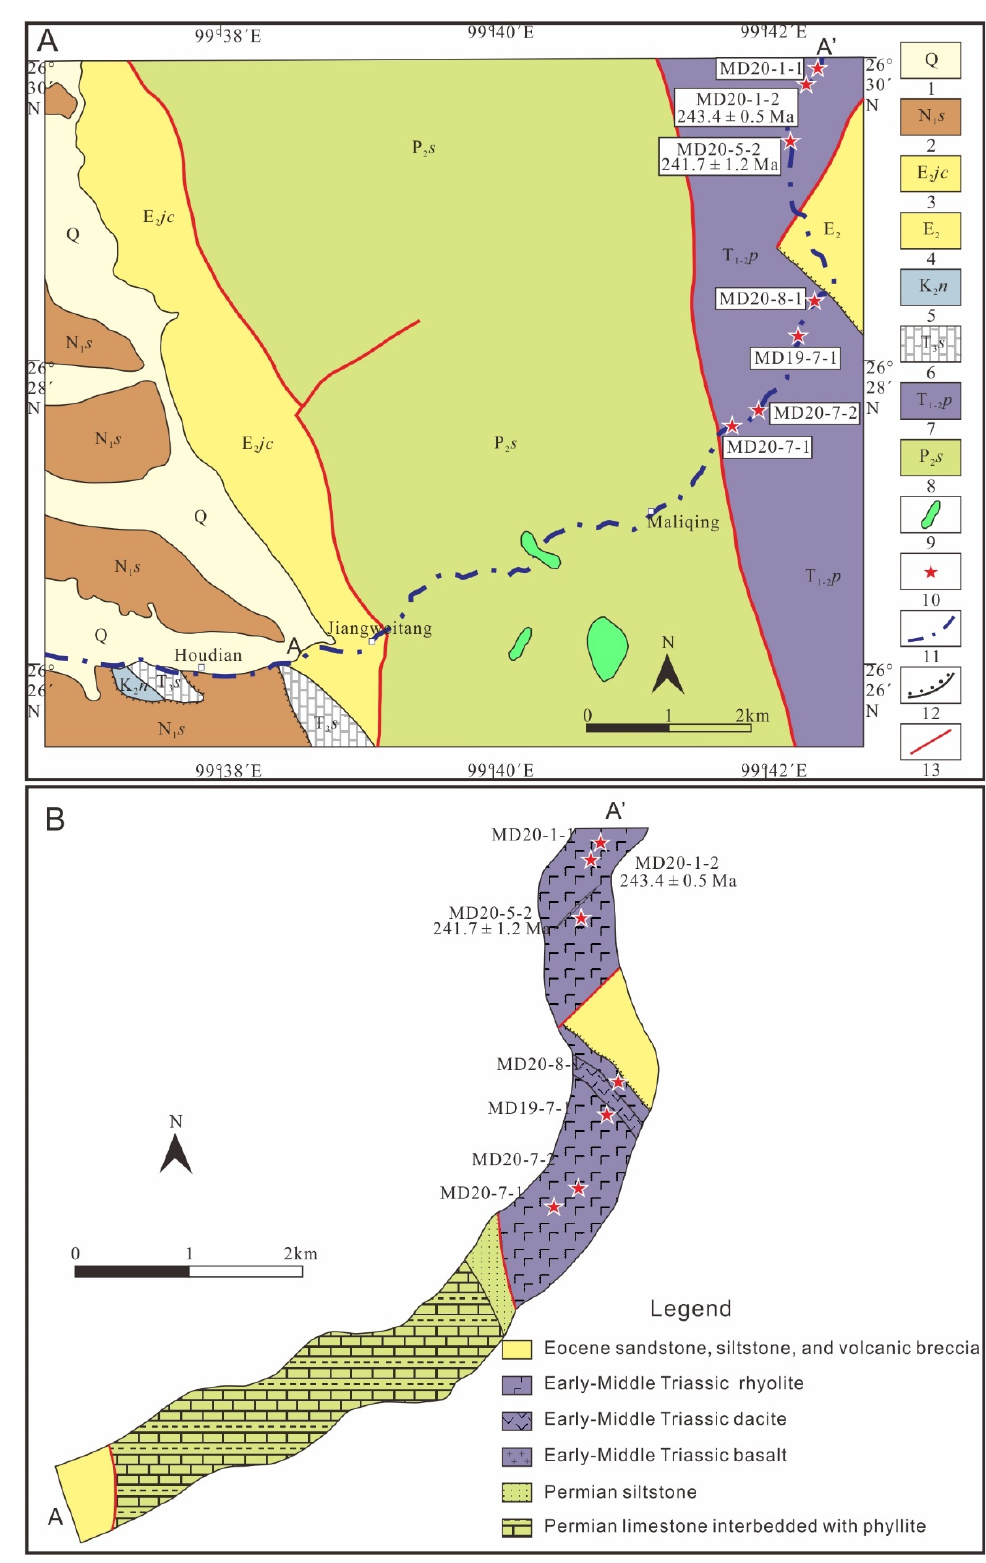
Figure 3. ( A ) Simplified geological map of Madeng area (modified from [14]). ( B ) Geological map of cross Section A-A’ (modified after [15]). Abbreviations: 1—Quaternary; 2—Sandstone and conglomerate of the Miocene Sanying Formation; 3—Sandstone and volcanic breccia of the Eocene Jianchuan Formation; 4—Eocene volcanic breccia clast-bearing siltstone and sandstone; 5—Siltstone and sandstone of the Cretaceous Nanxing Formation; 6—Limestone of the Late-Triassic Sanhedong Formation; 7—Dacite and rhyolite with thin basalt interlayer of the Early-Middle Triassic Pantiange